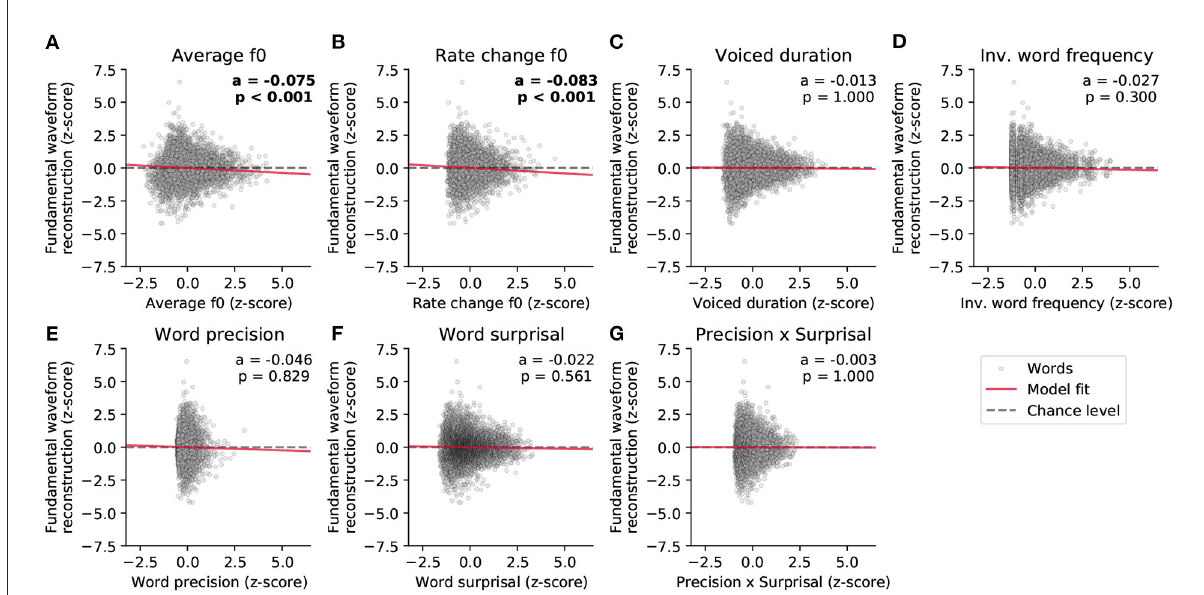
FIGURE5 Dependency of the strength of the neural response to the fundamental waveform on the different word-level features. (A–G) show the standardized single-word reconstruction scores averaged across 13 participants against the seven standardized word-level features. Each scatter plot shows data points corresponding to 5,732 words from the story presented to the participants during the EEG acquisition. The slopes of the red lines correspond to the coefficients obtained from the stepwise hierarchical regression. Each panel also depicts the model coefficient (a) for a given feature and the associated p -value (FDR-corrected). The gray dashed lines are horizontal and indicate no dependency.